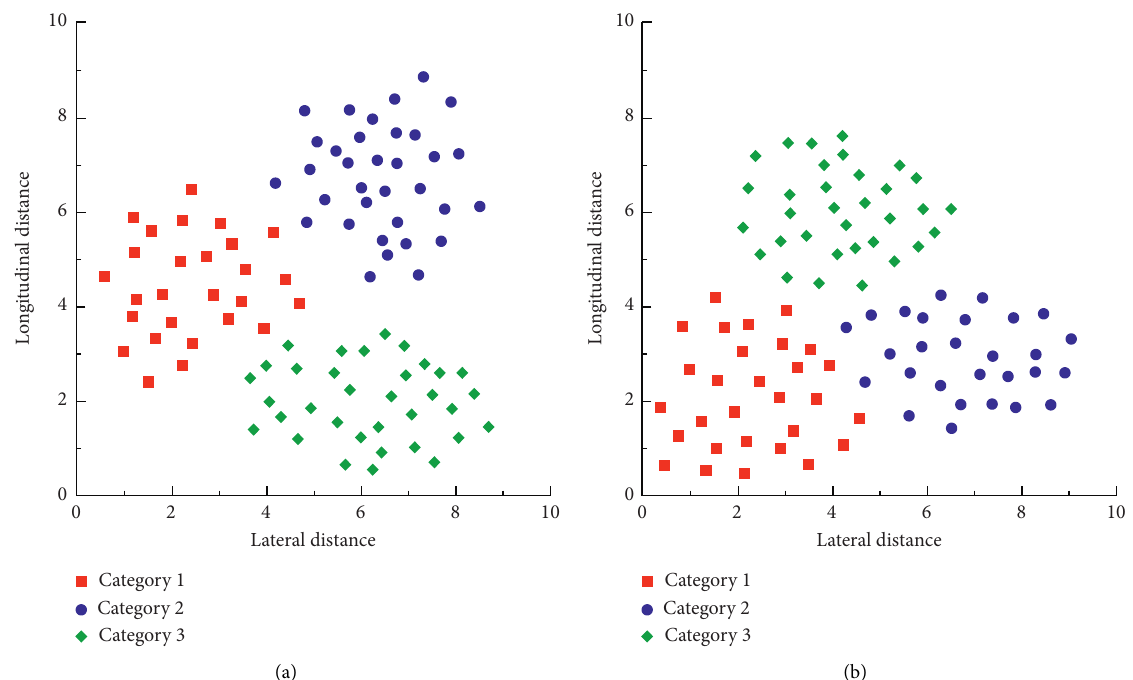
Figure 7: K-means clustering results of financial risk warning for similarity measure (a) and item clustering (b).